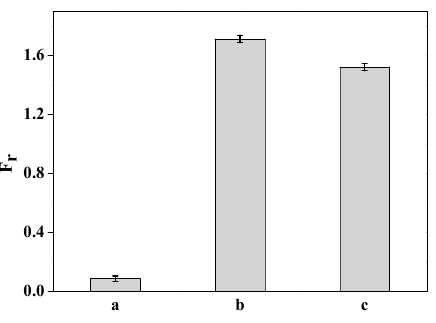
Figure 8. Selectivity of DNA probe when the target DNA concentration was 1.115 nmol/L. ( a ) Completely non-complementary DNA; ( b ) completely complementary DNA; and ( c ) a mismatched base-pair DNA.